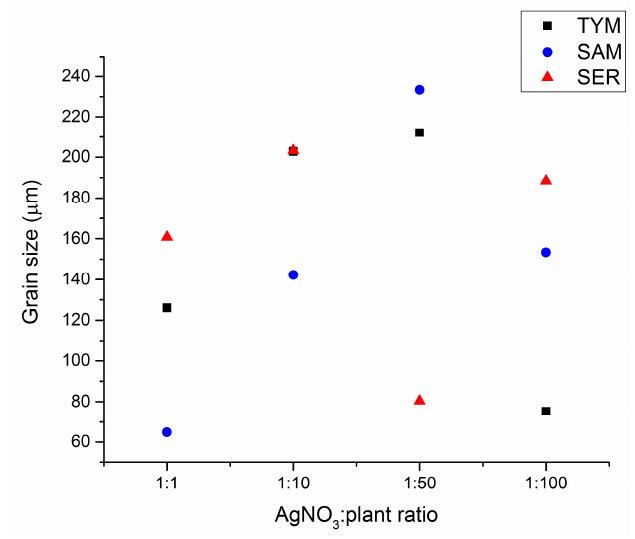
Figure 4. Grain size analysis of Ag:plant washed samples.